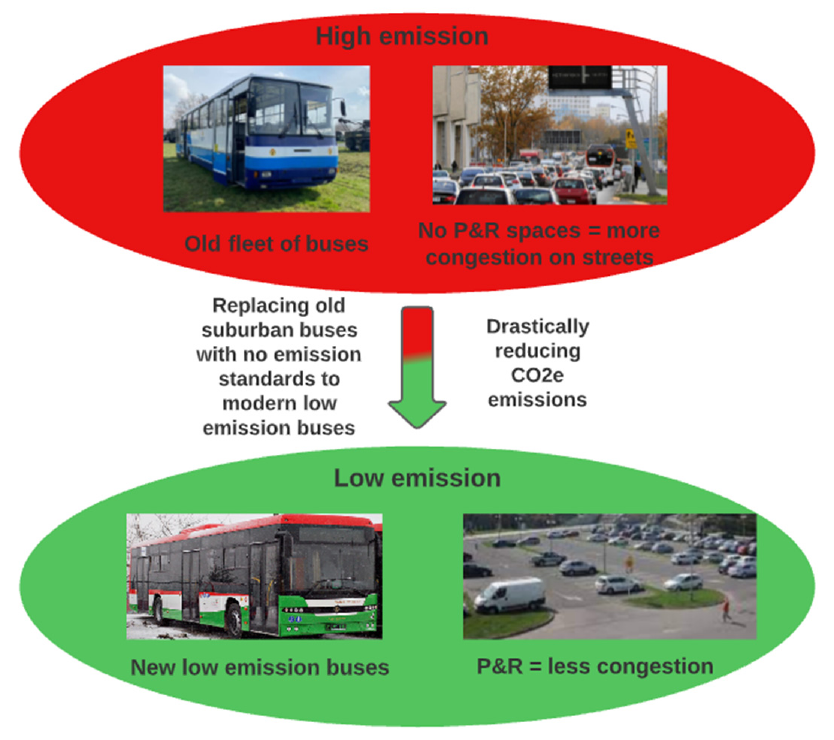
Figure 6. Overview of the researched buses with the general objectives of the work.